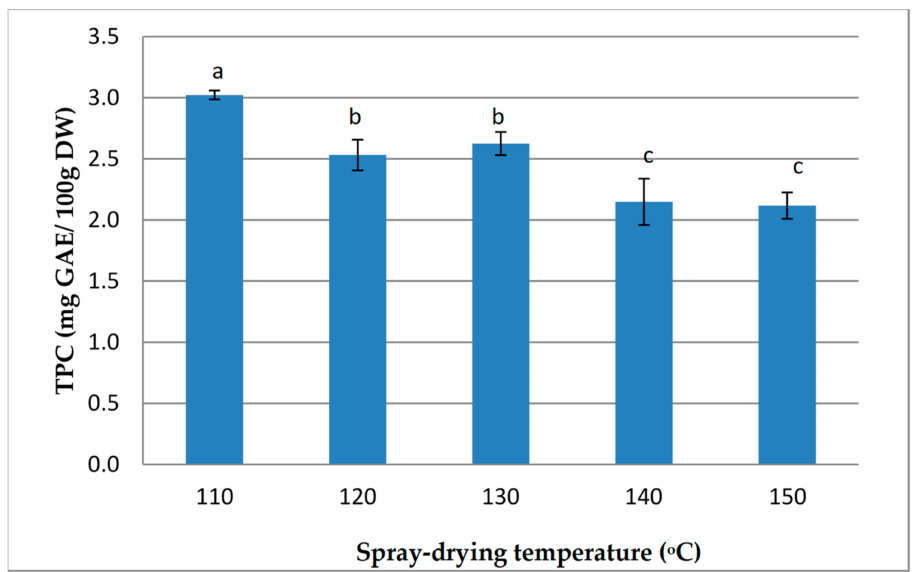
Figure 4. Total phenolic content (TPC) of lemongrass leaf extract powders at different spray-drying temperatures. All data are the mean ± SD. Values with different letters are significantly different ( p ≤ 0.05).